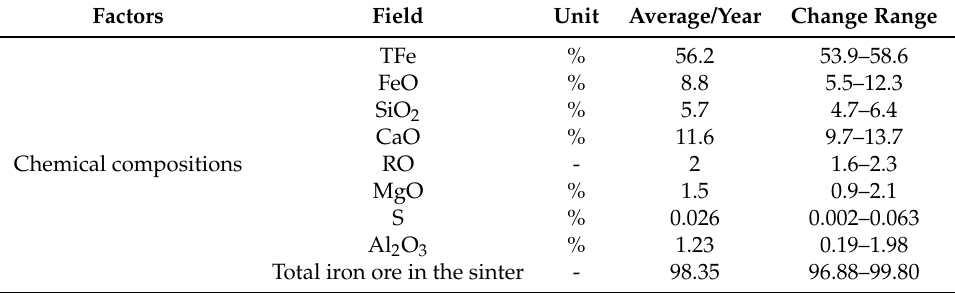
Table 1. Statistics for sintering compositions Factors Field Unit Average/Year Change